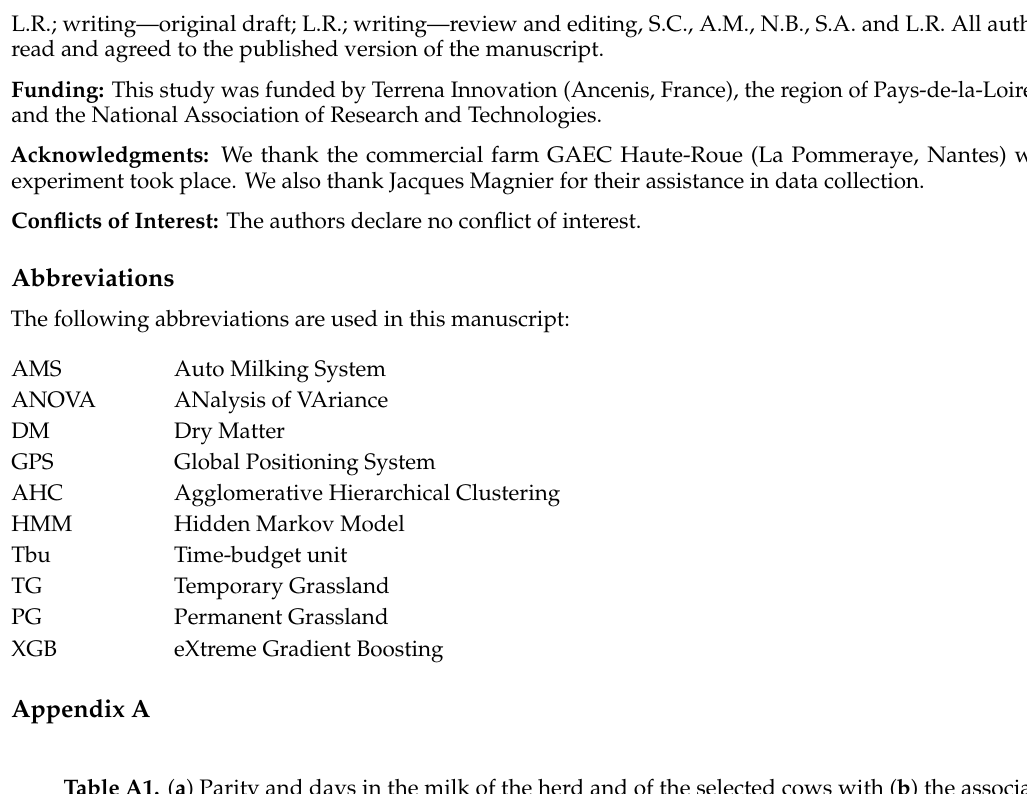
Table A1. ( a ) Parity and days in the milk of the herd and of the selected cows with ( b ) the associated summary